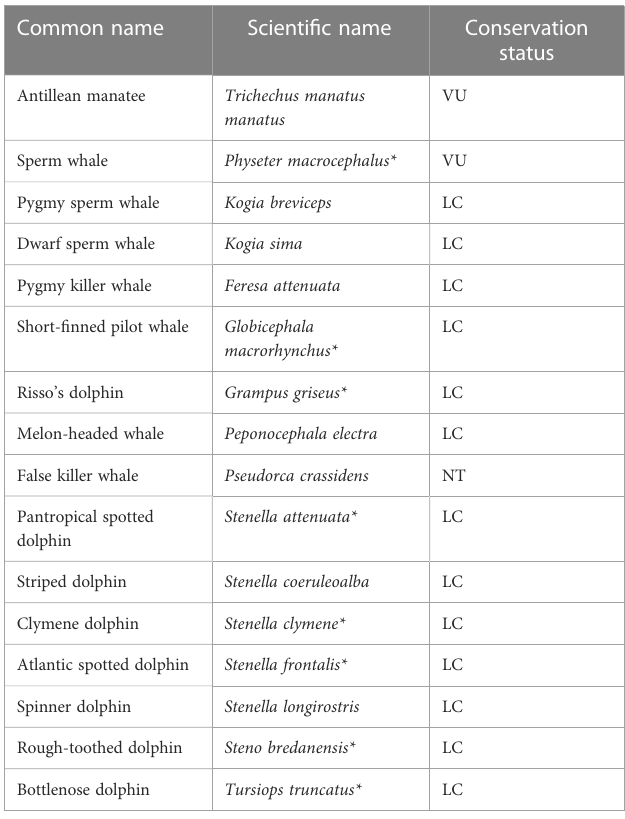
TABLE 3 Marine mammals of the western Gulf of